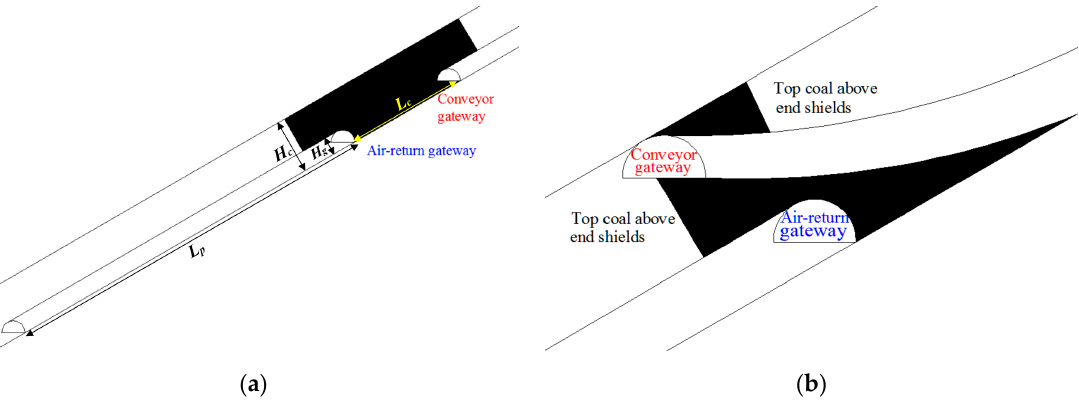
Table 2. Recovery ratio comparison.